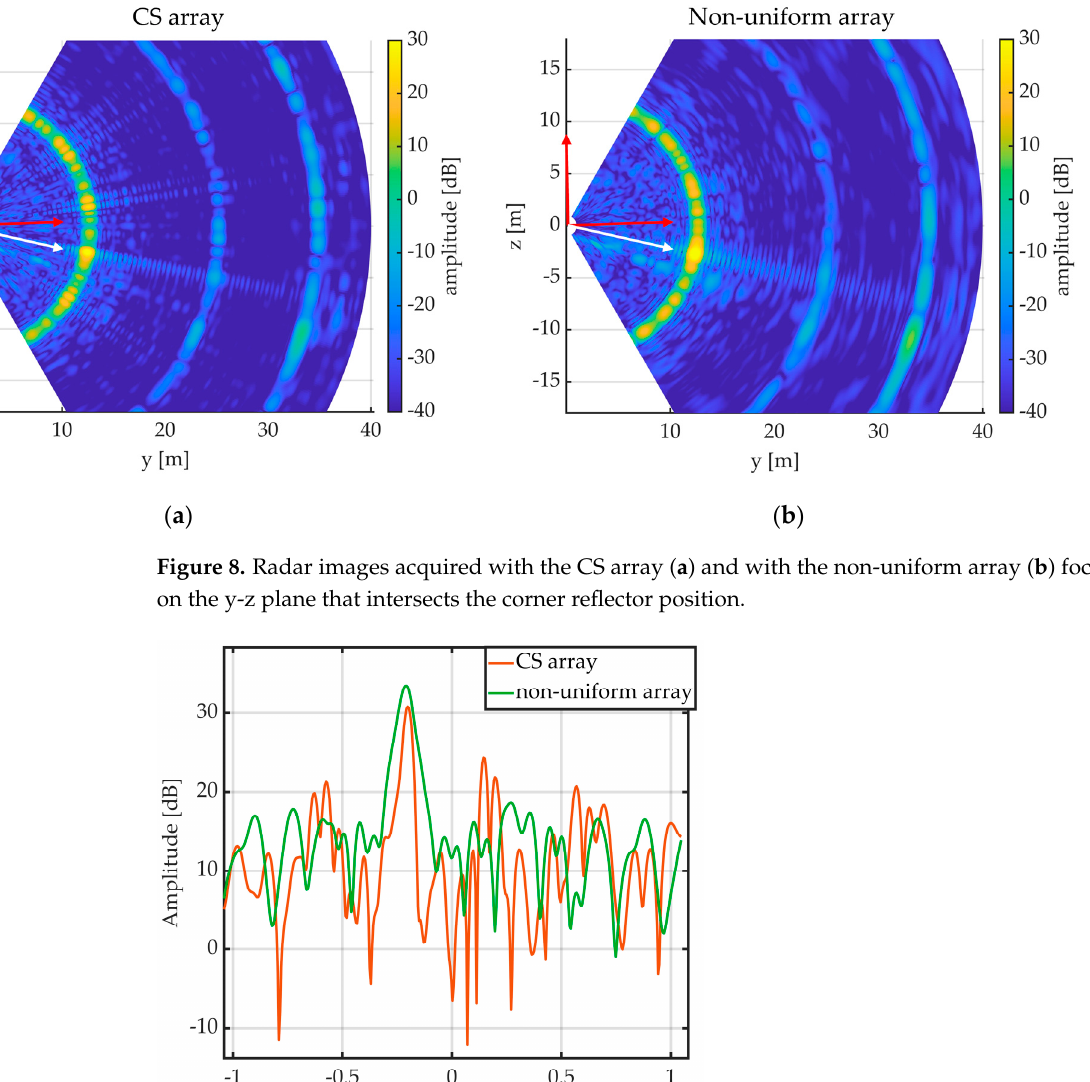
the radar is tilted up, the white arrow evidence the direction between radar and corner reflector.